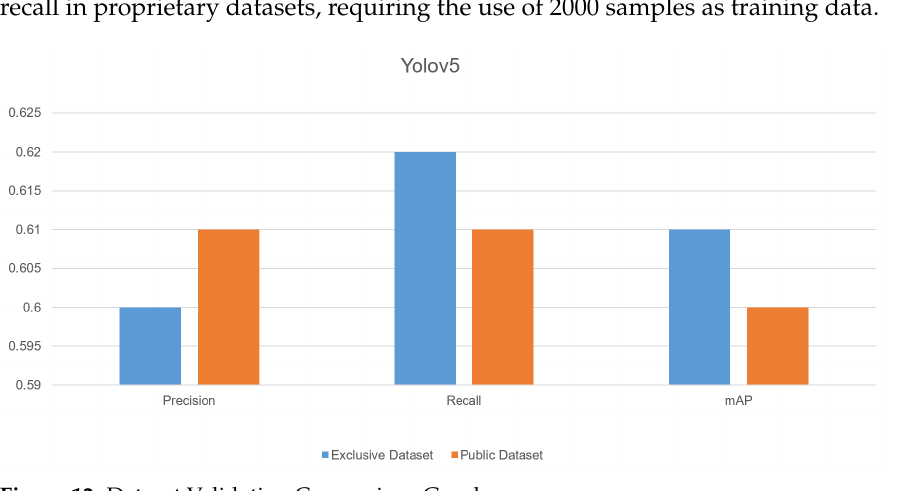
Figure 12. Dataset Validation Comparison Graph.